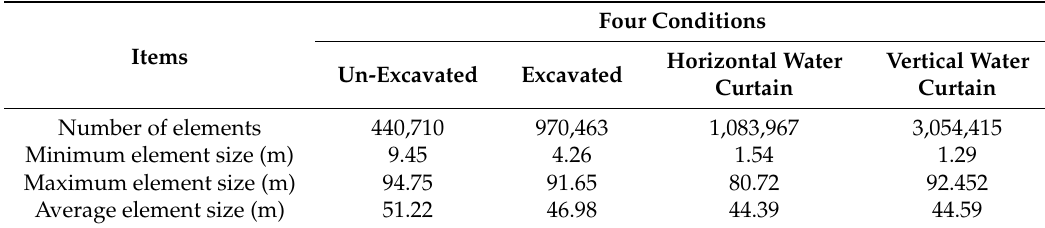
Table 1. The computational grid and the size resolution of the four